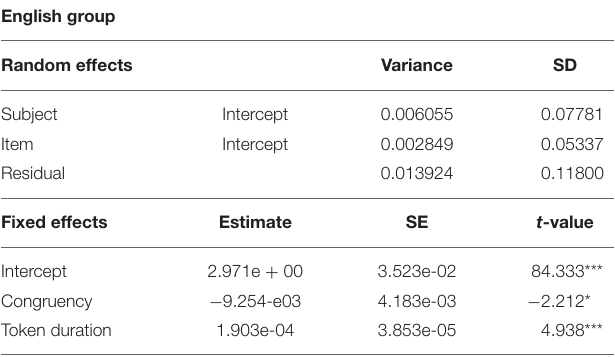
TABLE 4 | Results of the mixed-effects analysis for the English group.